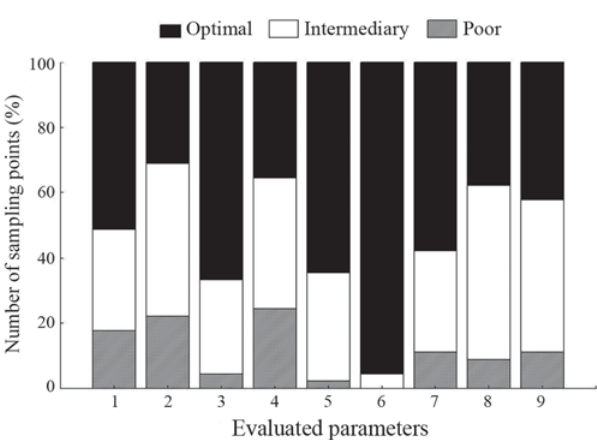
Fig. 2. Relative number of sampling points in different degrees of conservation for each evaluated parameter (1 - Available cover; 2 - Embeddedness; 3 - Velocity/depth regime; 4 - Sediment deposition; 5 - Channel flow status; 6 - Channel alteration; 7 - Bank stability; 8 - Vegetative protection; 9 - Riparian vegetative zone width).